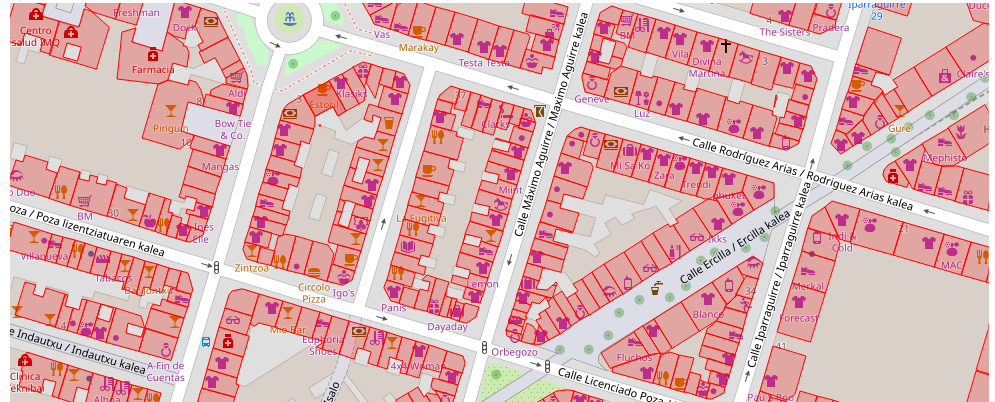
Figure 13. Example of how an area of Bilbao (Spain) would look after being